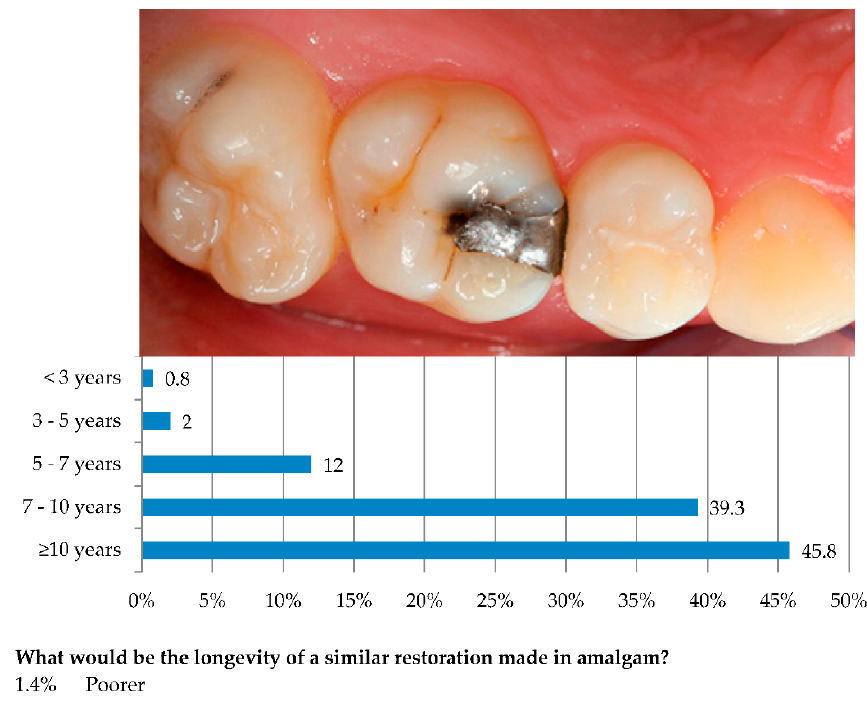
Figure 1. Patient Case 1: What longevity would you estimate if the amalgam restoration in this upper